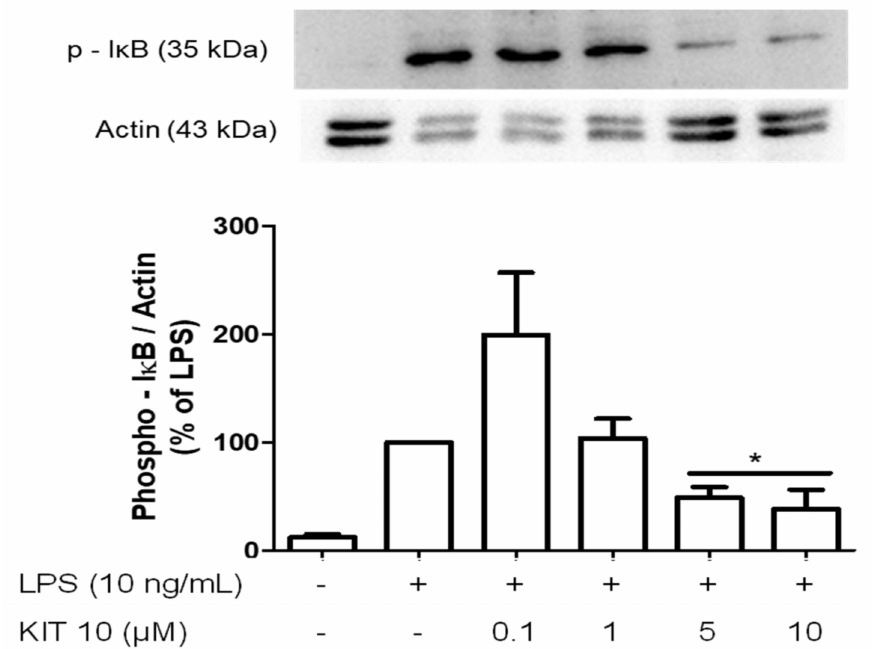
Figure 5. Effects of KIT 10 on I κ B- α phosphorylation in LPS-stimulated primary microglial cells. Microglia were pre-treated with KIT 10 for 30 min, afterwards, cells were incubated with or without LPS (10 ng/mL) for the next 15 min, and SDS gel electrophoresis followed by western blot per- formed. Representative original blots are included in Appendix A (Figure A1). Data are expressed as mean ± S.E.M. of three independent experiments. * p < 0.05 with respect to the LPS group (One-way ANOVA followed by the Newman-Keuls